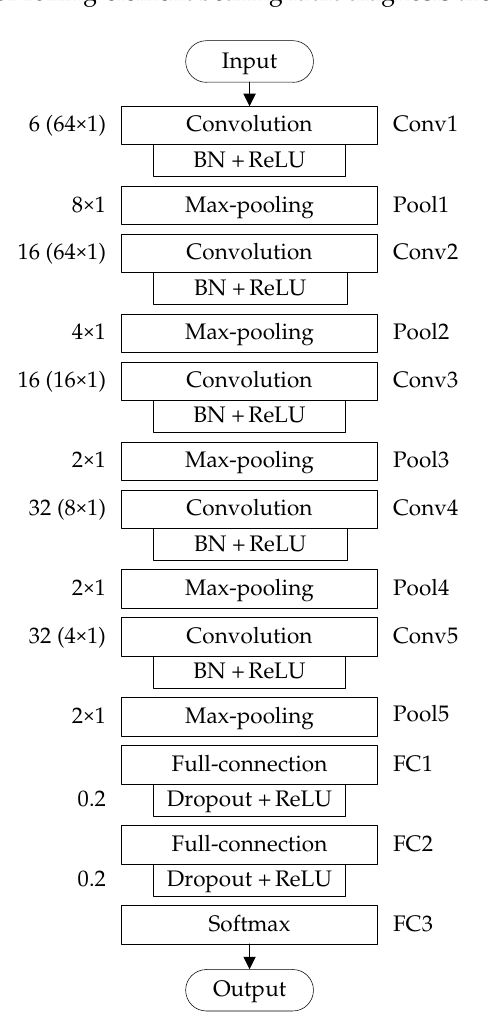
Figure 4. Structure of improved 1D LeNet-5 network for rolling-element bearing fault